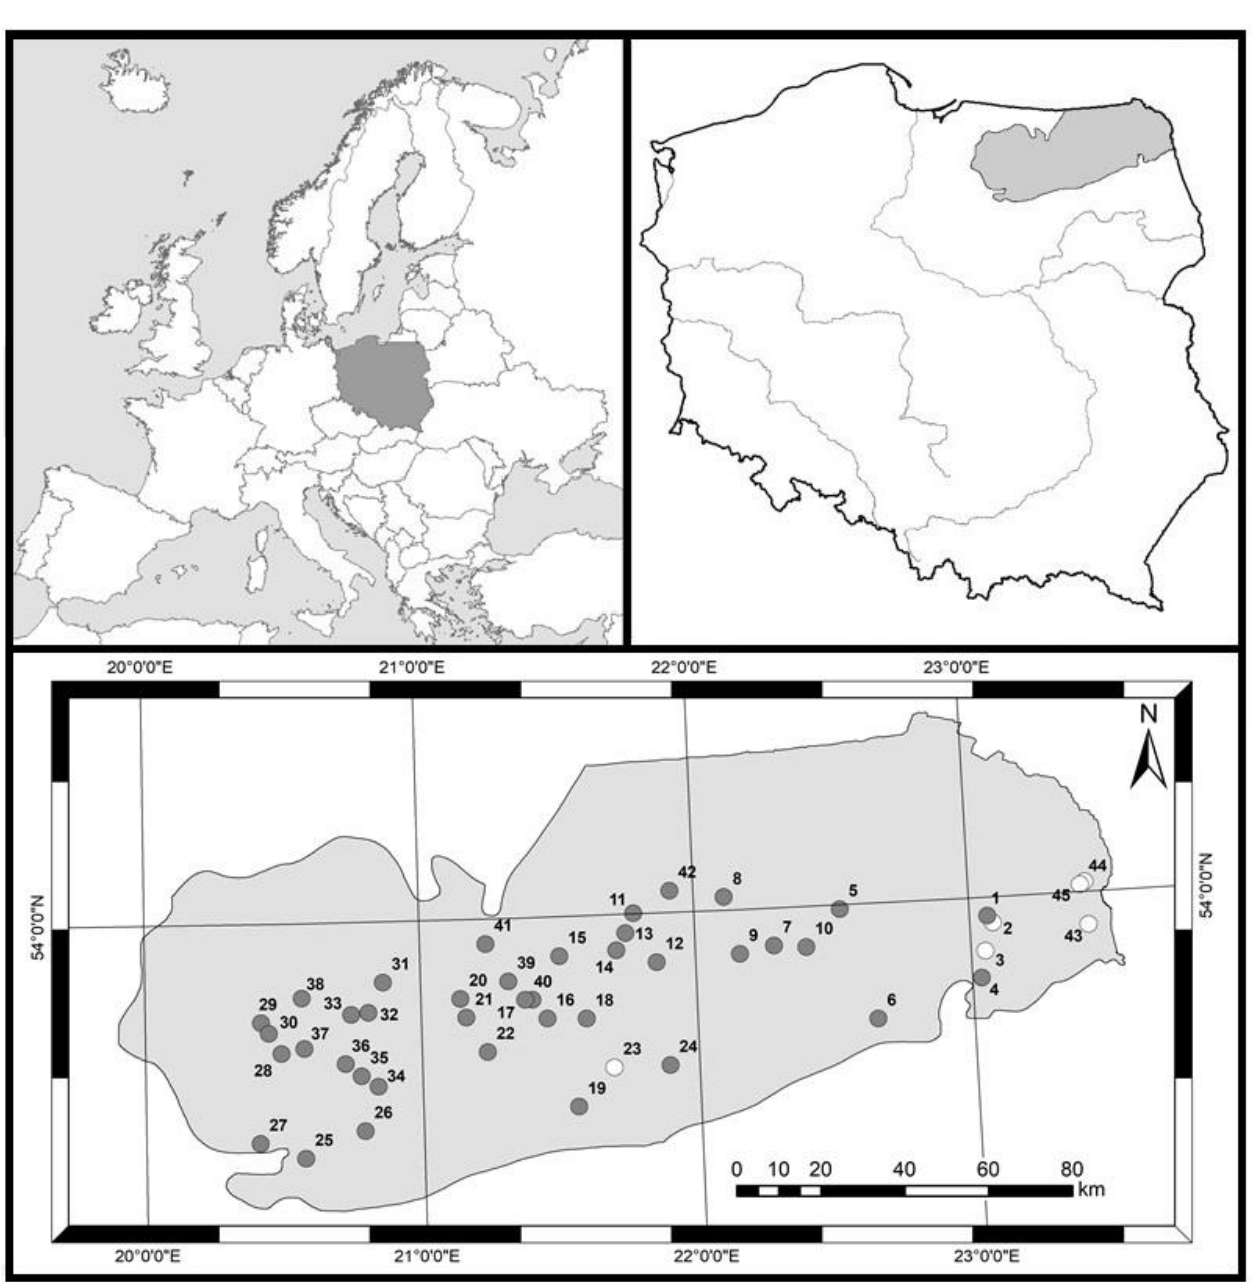
Figure 1. Location of studied lakes in East Baltic Lake District. The gray line shows the largest rivers